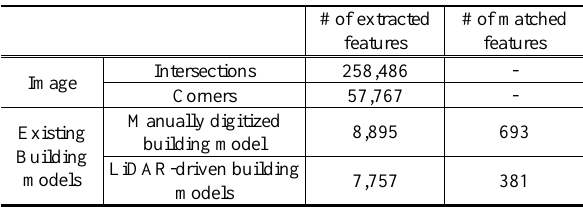
Table 1. Extracted features and matched